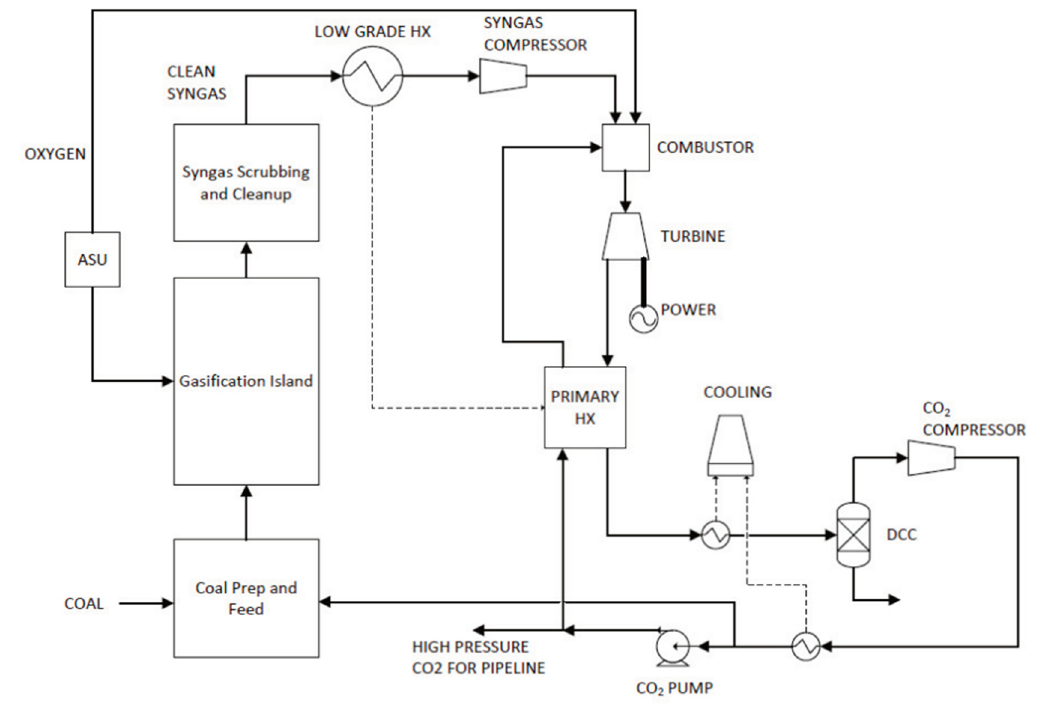
Figure 13. Schematic of the coal-fired Allam power cycle [115].